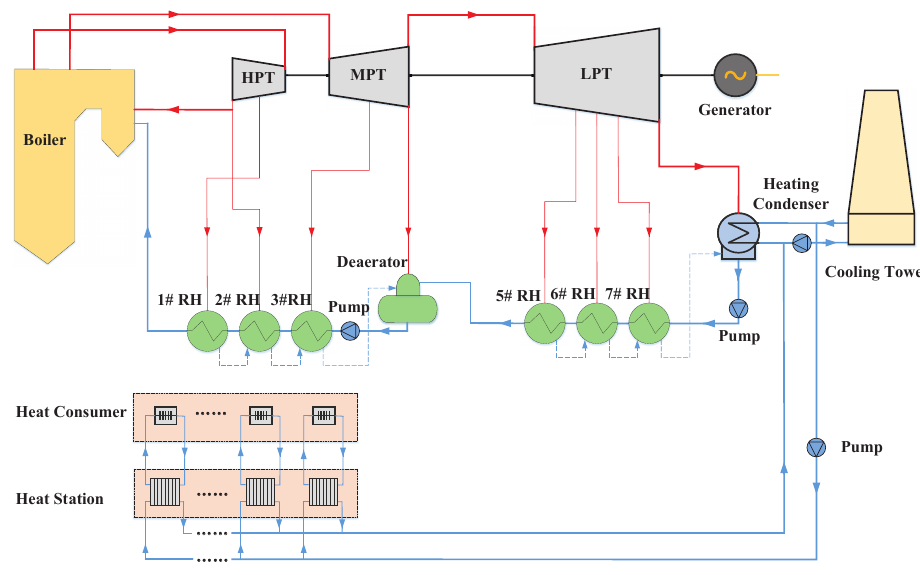
Figure 2. Schematic of the coal-fired CHP-HBP system.